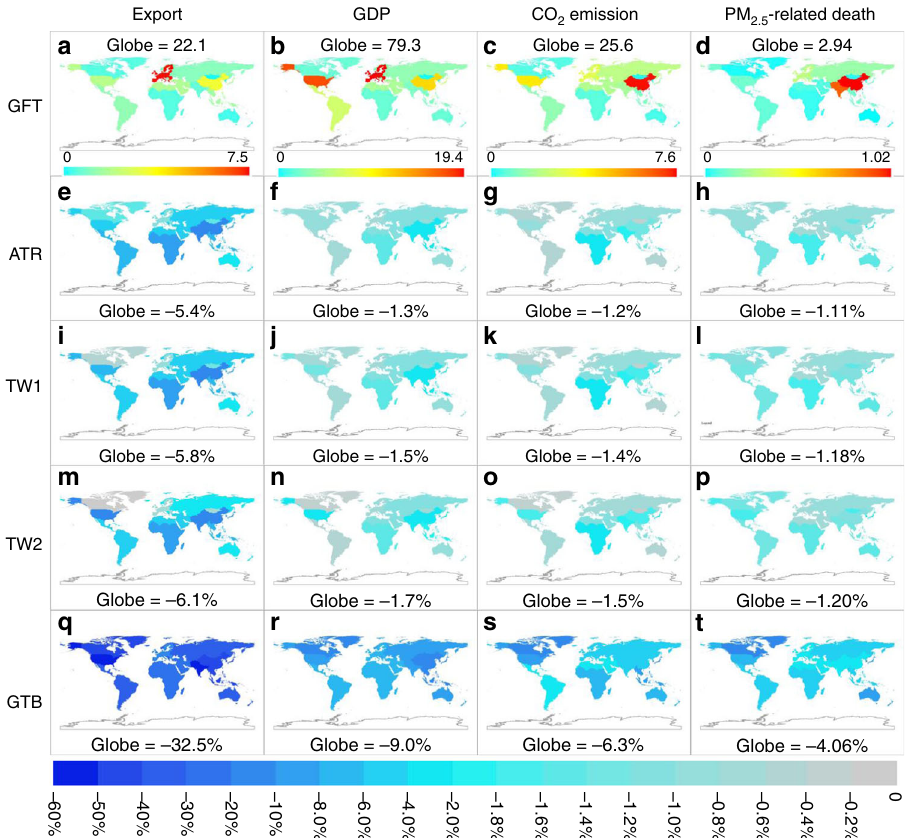
Fig. 1 Economic volume and environmental quality in each scenario. a – d Regional export volume (trillion $), GDP (trillion $), CO 2 emission (Pg), and PM 2.5 related premature death (million) in Scenario GFT. e – t Relative changes from global free trade (GFT) scenario to each alternative scenario. Results here only include scenario-dependent sources. Note that the color scales are linear in ( a – d ) and nonlinear in ( e – t